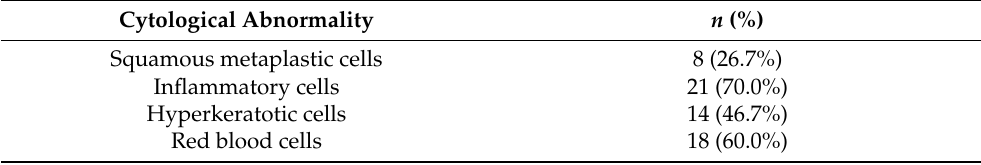
Table 1. Cytological observations revealed by urine cytology at baseline ( n = 30).